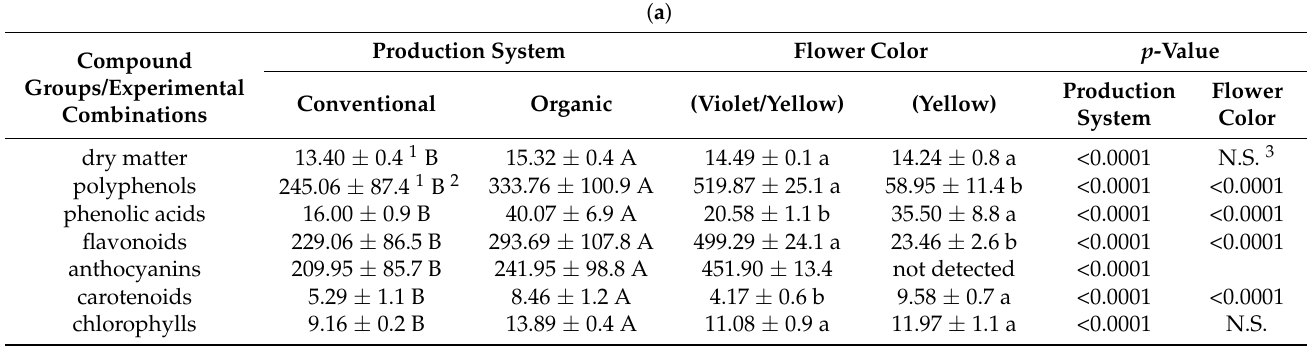
Table 1. ( a ) The mean value for groups of different bioactive compounds (counted sum) and the content of dry matter (in g/100 g F.W.) in pansy flowers with different flower colors and production systems (in mg/100 g F.W.). ( b ) The interaction between experimental factors for groups of different bioactive compounds (counted sum) and the content of dry matter (in g/100 g F.W.) in pansy flowers with different flower colors and production systems (in mg/100 g